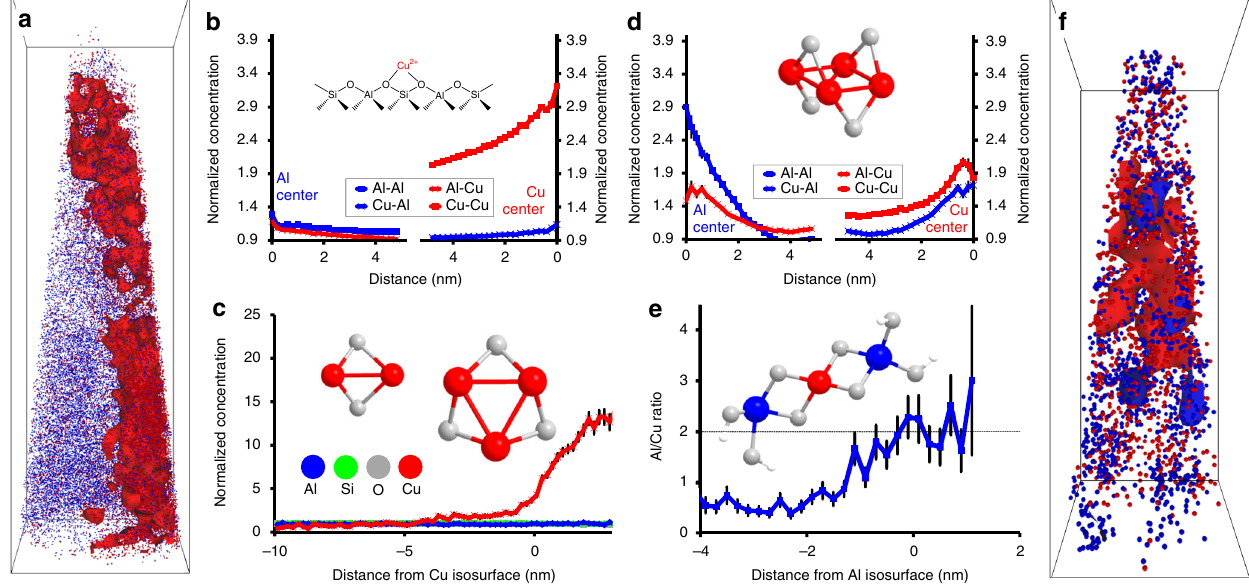
Fig. 2 Overview of atom probe tomography results for fresh and aged Cu-ZSM-5. a Reconstructed needle of fresh Cu-ZSM-5 ( 1 , full results are in Supplementary Fig. 22) with Cu (red) and Al (blue) ions shown and 1.8% Cu isoconcentration surfaces shown, this is also provided as Supplementary Movie 1. Bonding box dimensions are 40 × 43 × 140 nm 3 . b Radial distribution functions (RDFs) in fresh Cu-ZSM-5 for Al and Cu centers. Strong Cu – Cu af fi nity is indicated, as well as much weaker, but still signi fi cant af fi nities between all other species. An Al – Cu af fi nity is expected due to Cu exchanging onto paired Al sites, as indicated in the schematic. c Normalized compositional histogram across the 1.8% Cu isoconcentration surfaces in fresh Cu-ZSM-5, with the structures of potential CuO species shown. d RDFs in aged Cu-ZSM-5 ( 3 , full results are in Supplementary Fig. 26) for Al and Cu centers, with the structure of a potential CuO species shown. Strong af fi nities are indicated between all species, pointing to the formation of copper aluminate domains after aging due to Cu – Al aggregation. e Al/Cu ratio across the 8% Al isoconcentration surfaces in aged Cu-ZSM-5, the stoichiometry of Al/Cu = 2 is consistent with CuAl 2 O 4 spinel, and the O/Cu and O/Al values are also stoichiometric, see Supplementary Fig. 27. f Reconstructed needle of aged Cu-ZSM-5 ( 3 ) with 5% Cu and 8% Al isoconcentration surfaces shown, this is also included as Supplementary Movie 3. Bonding box dimensions are 15 × 15 × 43 nm 3 . All error bars were calculated from counting statistics using the method described in ref.